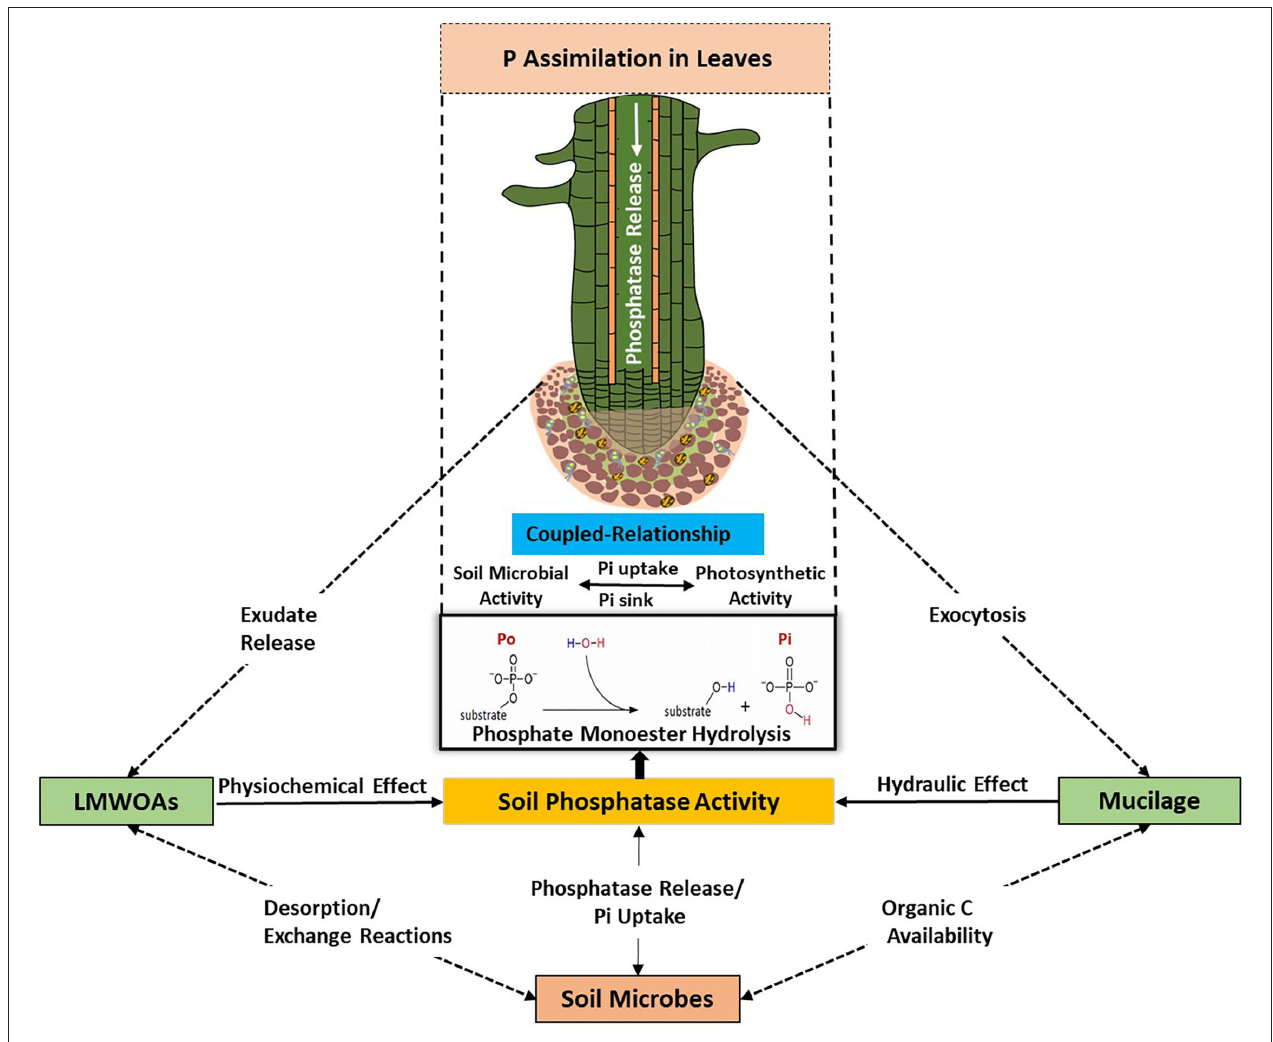
FIGURE 2 | A scheme visualizing the coupled relationship between plants and soil microbes for the acquisition of available soil P resources and/or P mineralization induced via phosphatase activity. Root exudation of mucilage and LMWOAs exert favorable physicochemical and hydraulic changes in the rhizosphere for P accessibility. Soil microbes ensure a mutual relationship with plant roots by the production of phosphatases and release of LMWOAs, which favor P supply from soil P